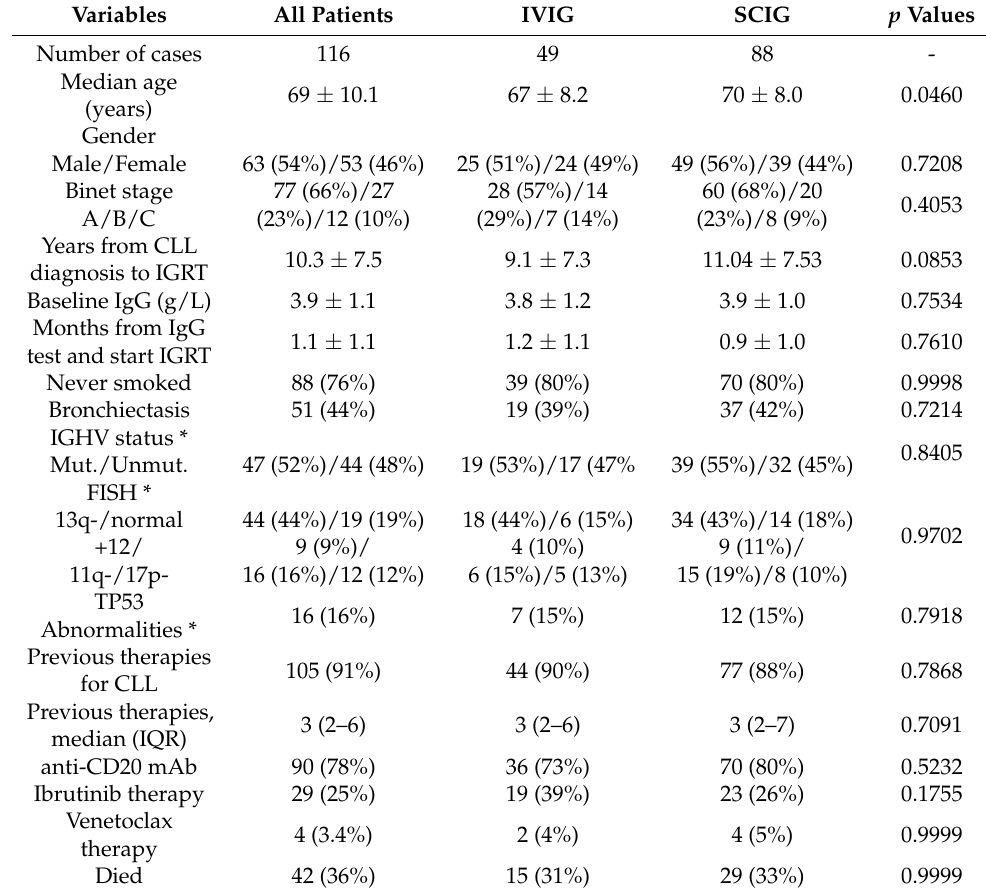
Table 1. Clinical and biological features of